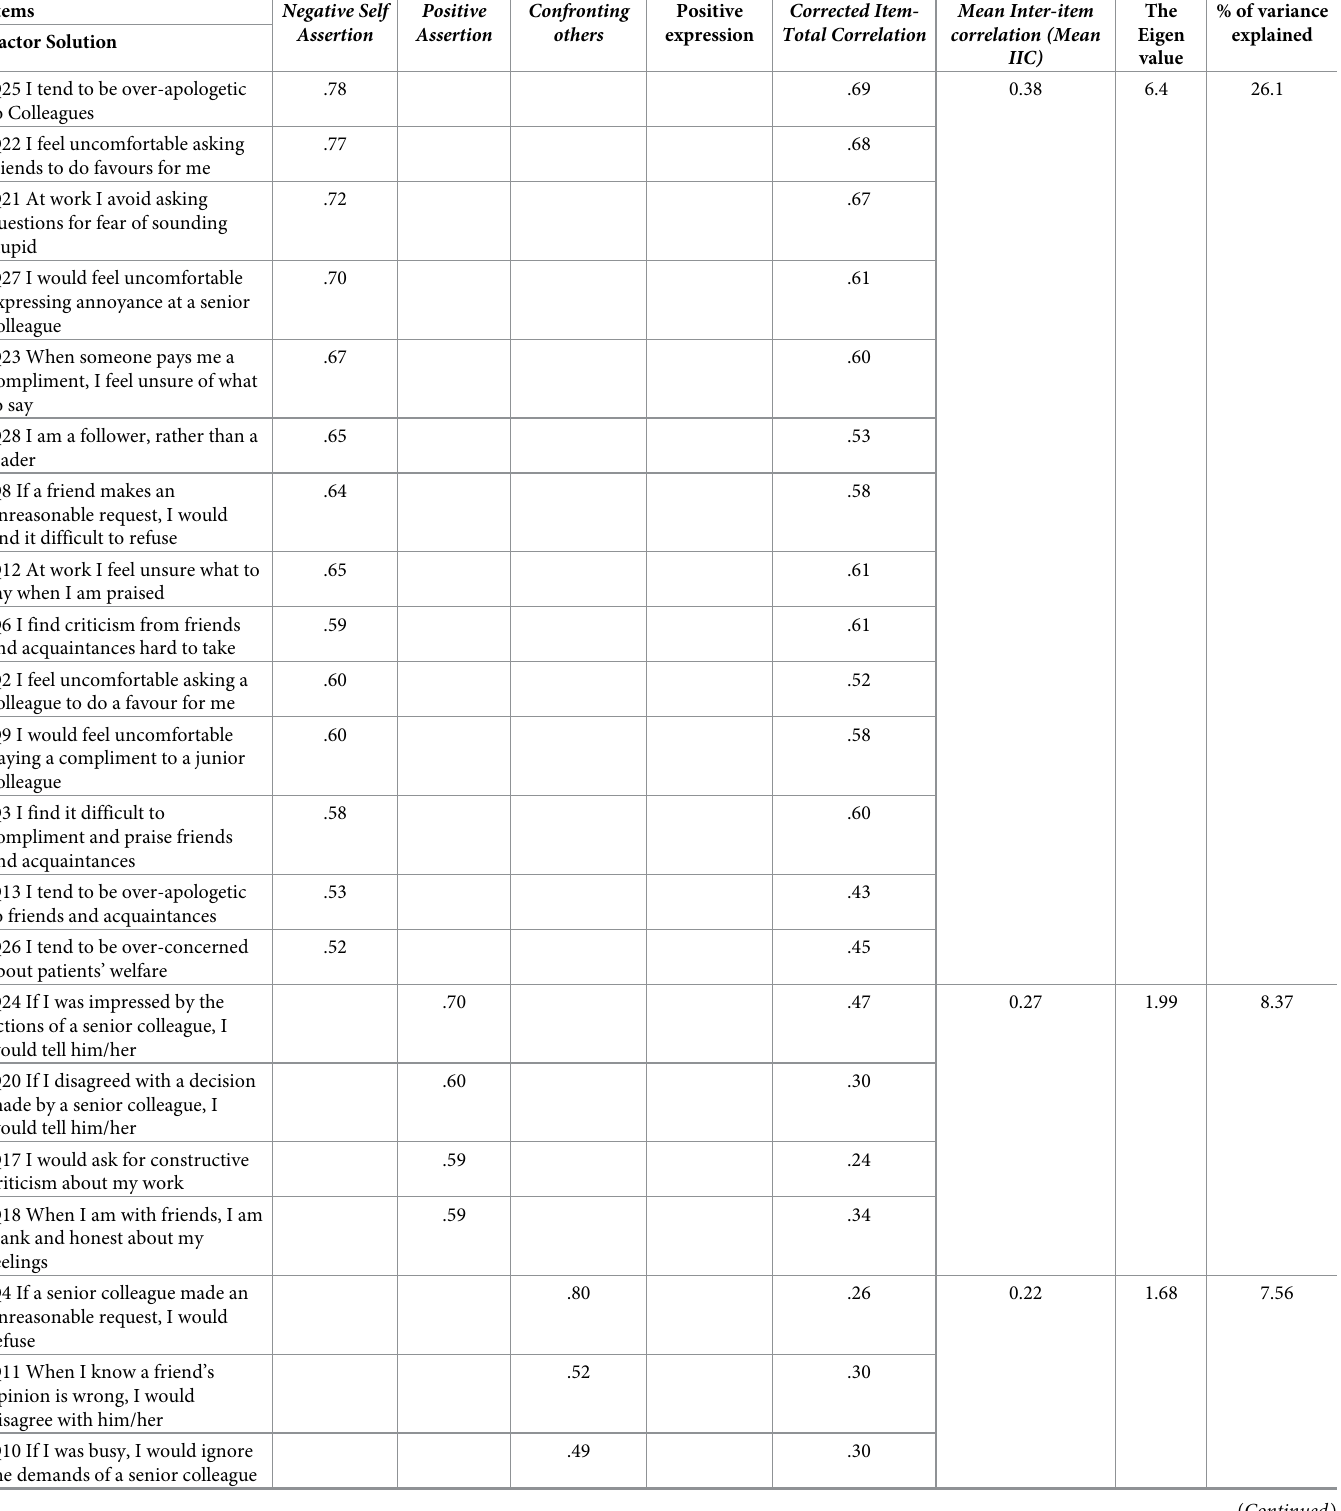
Table 2. Exploratory Factor Analysis (EFA) of the 23-items factor solution of the Arabic version of the Irish Assertiveness Scale. Items Factor